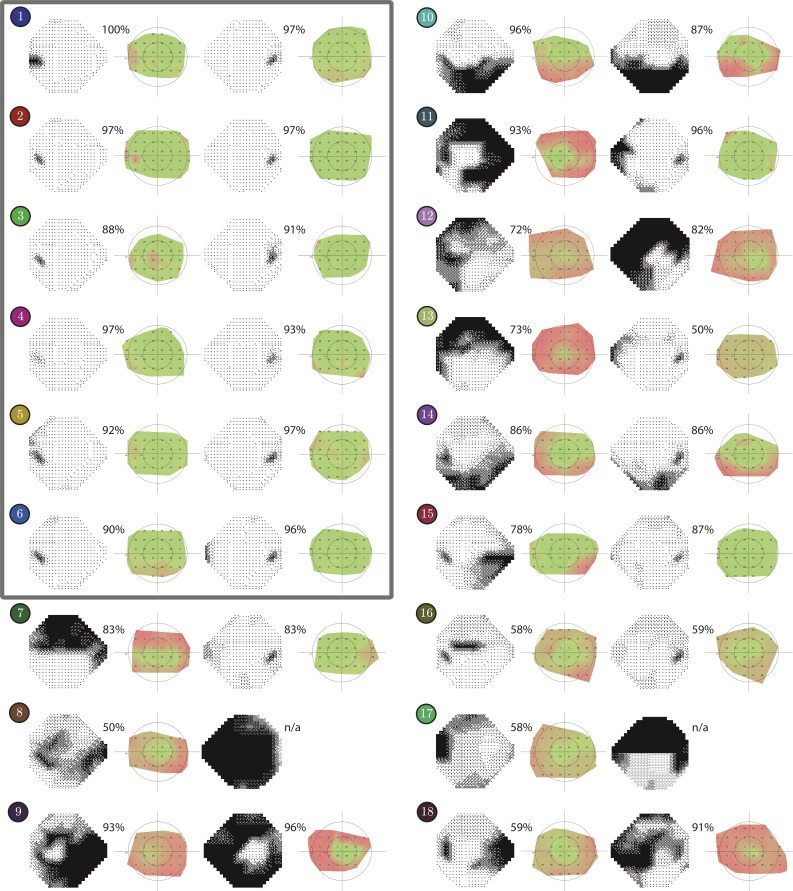
Concordance in pointwise sensitivity (Eyecatcher versus HFA). Results are shown for each individual eye, with the HFA Greyscale on the left, and the corresponding Eyecatcher Kriging surface on the right. If concordance was good, then black areas in the HFA Greyscale should appear as red areas on the Eyecatcher Kriging surface. Numbers indicate the percentage of concordant values at each 24-2 location present in both maps. Markers correspond to the list of individuals in the Table. Individuals 1–6 (gray rectangle) indicate healthy controls.